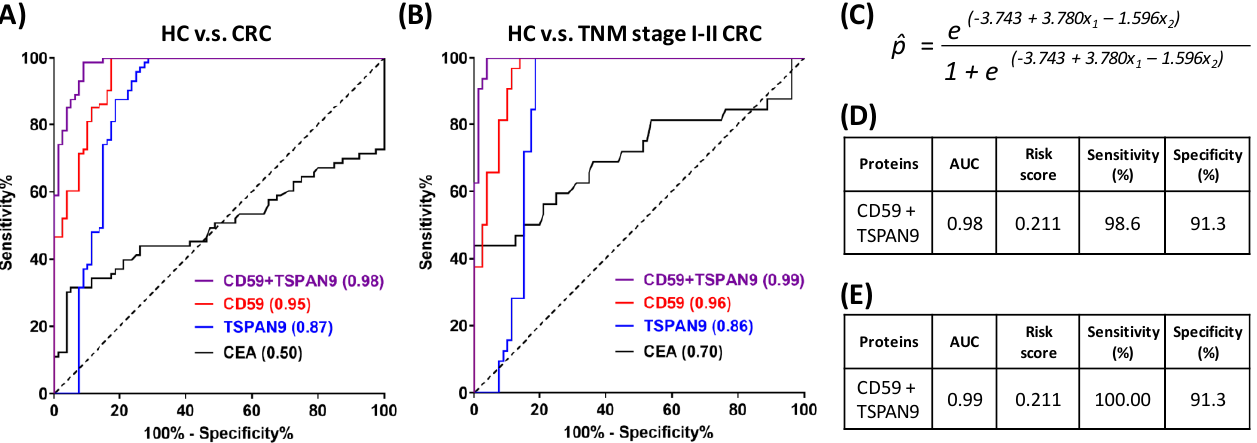
Figure 6. ROC curve analysis of CD59 and TSPAN9 in discriminating CRC patients from HC subjects. ( A ) The discriminatory power of plasma EV CD59, TSPAN9, and CD59 combined with TSPAN9 was evaluated in all HC subjects and CRC patients using ROC curve analysis. ( B ) The discriminatory power of these targets was further evaluated in all HC subjects and in TNM stage I and II CRC patients. ( C ) The equation for probability in risk evaluation was generated by logistic regression. ( D , E ) AUC values, risk score, sensitivity and specificity of CD59 and TSPAN9, used as a biomarker panel to distinguish CRC ( D ) or TNM stage I/II CRC ( E ) patients from HC subjects.